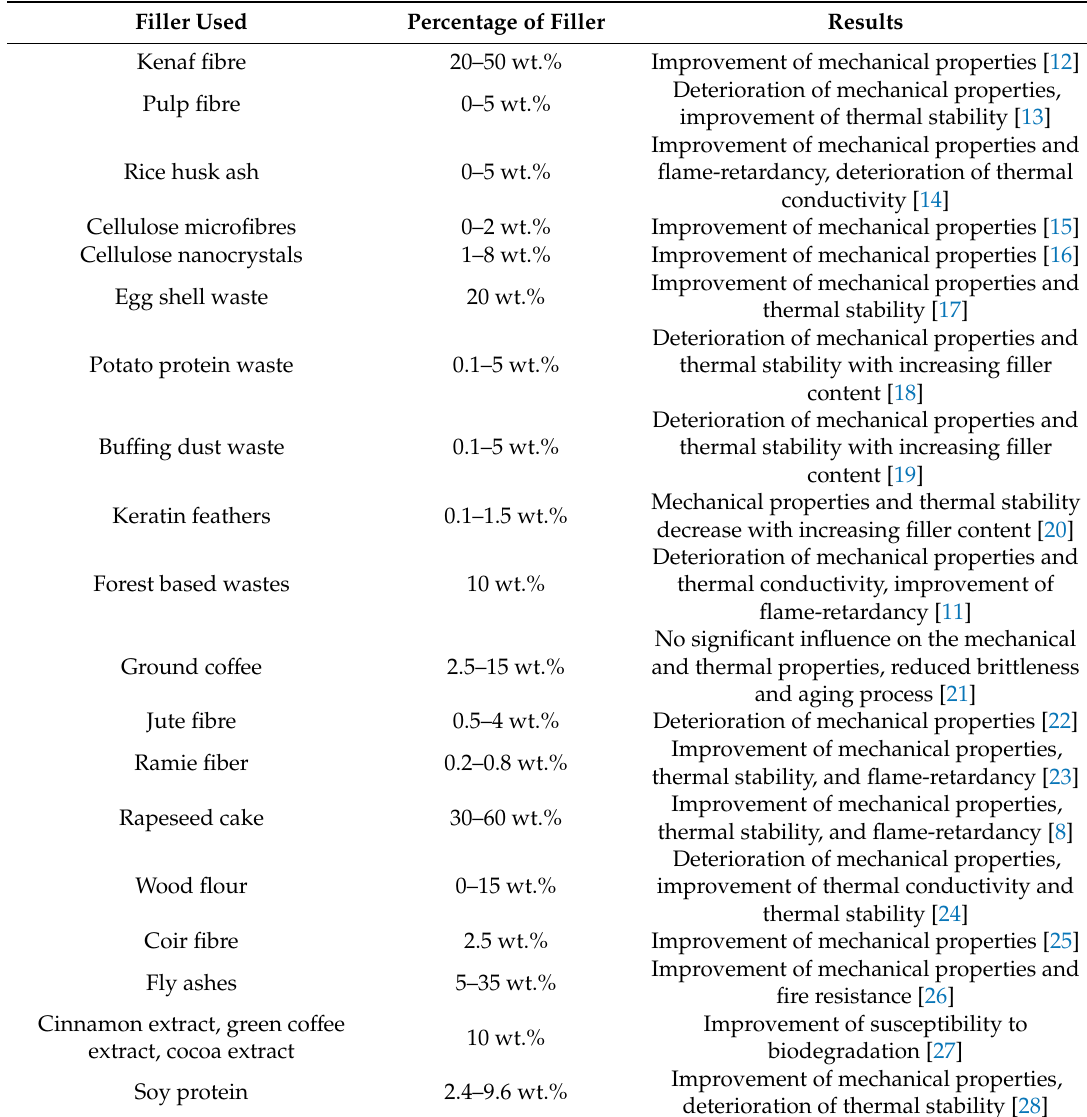
Table 1. Recent works on filler reinforced polyurethane foams—e ff ect of di ff erent fillers on mechanical properties of polyurethane